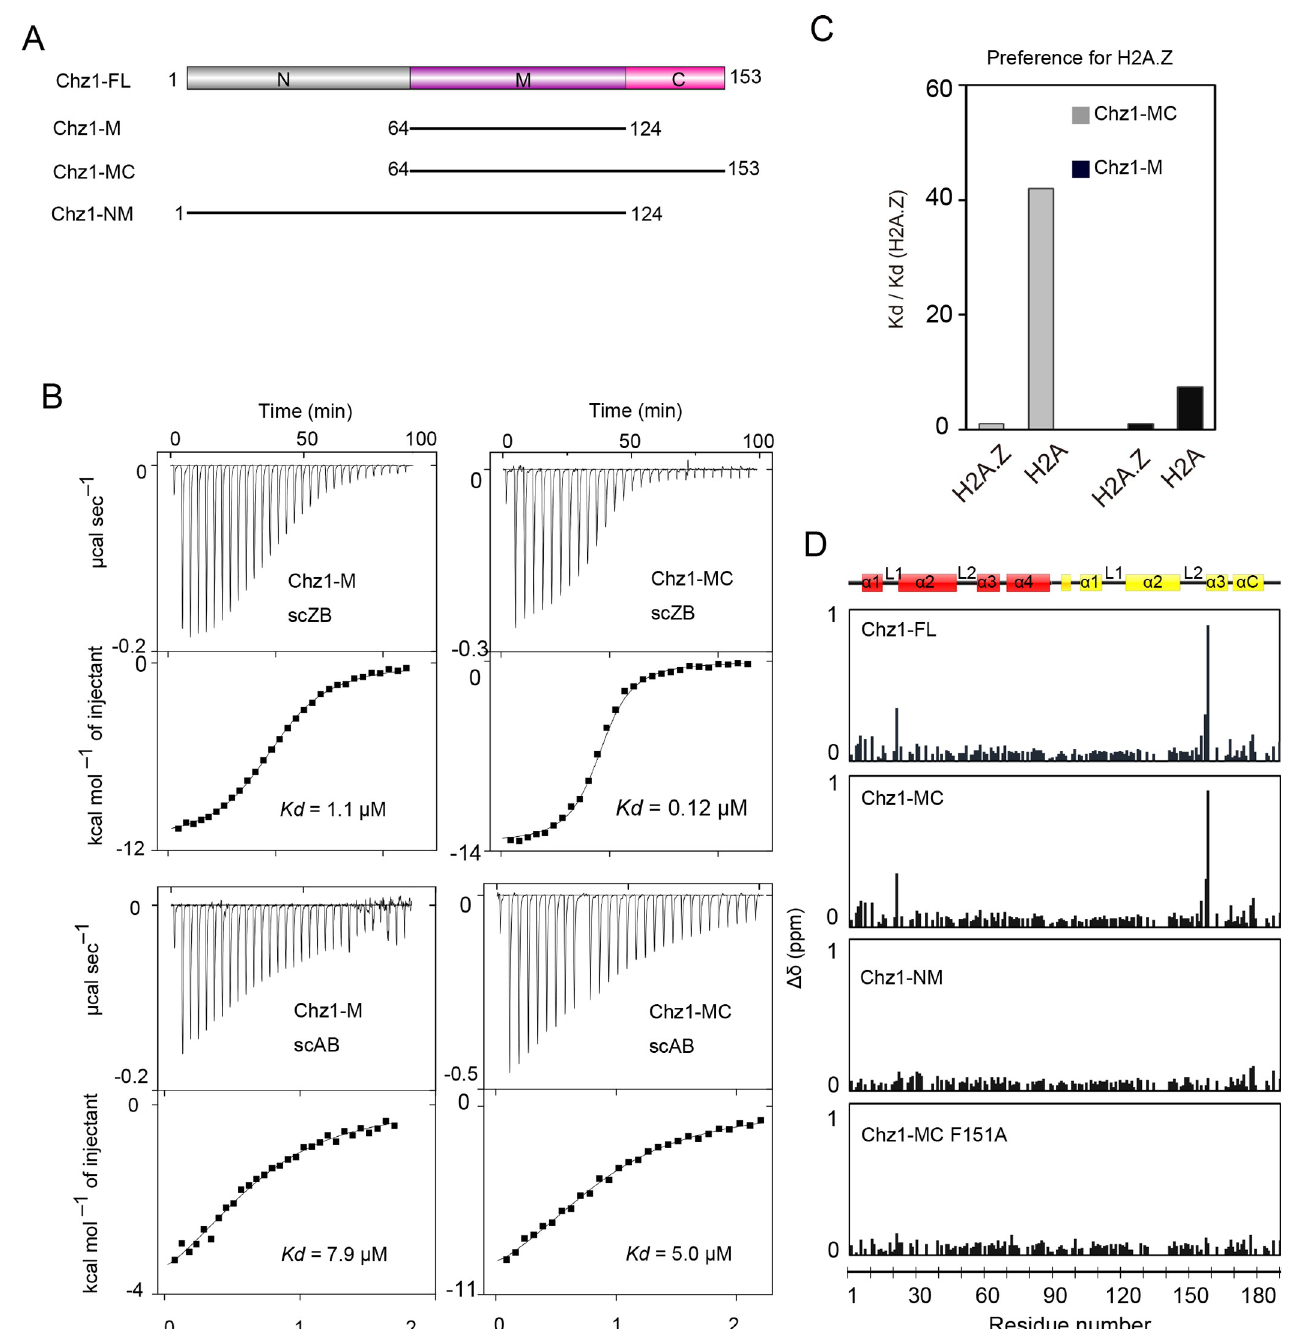
Fig 1. Identification of Chz1 regions dictates the preference for H2A.Z. (A) Schematic view of Chz1-FL according to a previous mapping result. Shown below the scheme include the N-terminal region (residues 1–63), middle region (residues 64–124), and C-terminal region (residues 125–153) of Chz1 termed Chz1-N, Chz1-M, and Chz1-C, respectively. (B) Effect of Chz1-MC and Chz1-M on the binding of H2A.Z-H2B dimer and H2A-H2B dimer by ITC. Histone dimers were titrated by Chz1-M (left) and Chz1-MC (right). The underlying data can be found in S1 Data. (C) Effect of Chz1-MC and Chz1-M on dictating the preference for H2A.Z. The folds of binding affinity decrease between all histone dimers (in single-chain form) and scZB are denoted as Kd/Kd (H2A.Z) and calculated for comparison. The underlying data can be found in S1 Data. (D) CSP mapping analysis of H2A.Z-H2B residues interacting with different Chz1. The 1 H- 15 N HSQC spectrum of 15 N labeled scZB in complex with Chz1-M serves as the reference spectra to monitor the CSP changes. The CSP changes are calculated as Δδ = [( Δδ 1 H) 2 + ( Δδ 15 N/5) 2 ] 1/2 and plotted as a function of scZB residues for comparison. From the top to bottom: CSP changes of scZB residues interacting with Chz1-FL, Chz1-MC, Chz1-NM, Chz1 F151A mutant. On the top is displayed the schematic view of scZB and secondary structures of H2A.Z